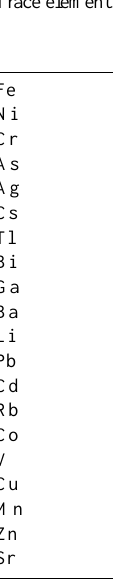
Table 3. Annual amount of trace element accumulation excess (kg yr − 1 ) by P. oceanica for the Mediterranean basin according to the estimates of the total cover of P. oceanica (50000km 2 ) (Pasqualini et al., 1998). Positive or negative values indicate either incorpora- tion or release by P. oceanica ,